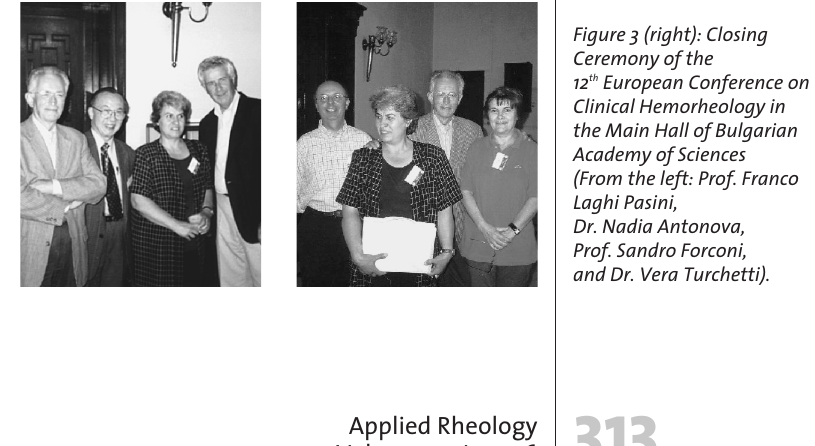
Figure 2 (left): Closing Ceremony in the Main Hall of the Bulgarian Academy of Sciences. From the left: Prof. Sandro Forconi , Prof. Shu Chien, Dr. Nadia Antonova, and Prof. H. Schmid-Schonbein. Figure 3 (right): Closing Ceremony of the 12 th European Conference on Clinical Hemorheology in the Main Hall of Bulgarian Academy of Sciences (From the left: Prof. Franco Laghi Pasini, Dr. Nadia Antonova, Prof. Sandro Forconi, and Dr. Vera